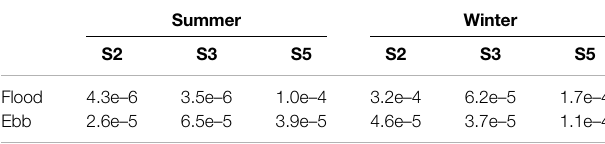
TABLE 2 | The mean value of z 0 for hydrodynamic rough fl ow for fl ood and ebb tides in summer and winter.